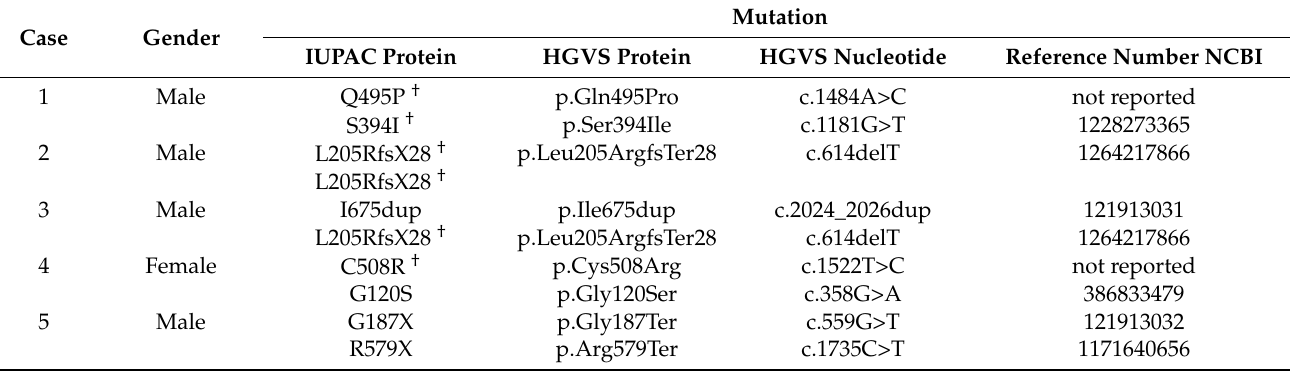
Table 6. Molecular analysis of patients with congenital chloride diarrhea (CCD) included in the present